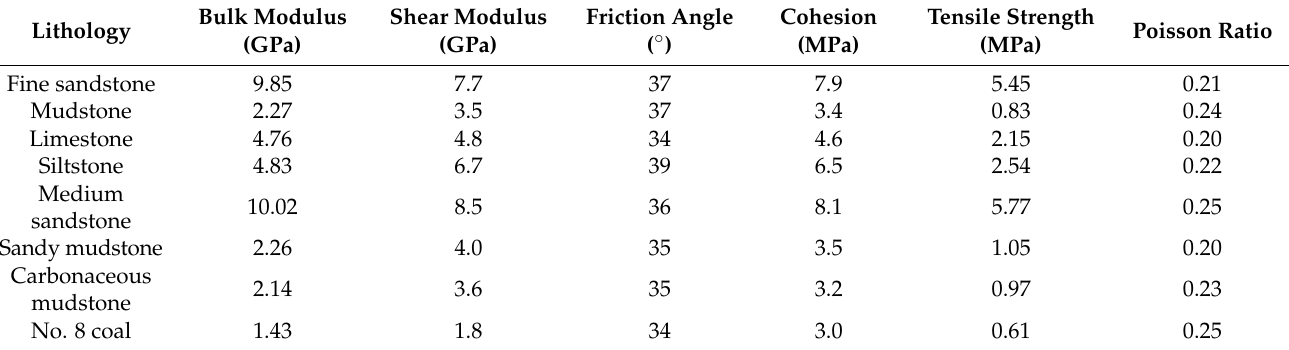
Figure 3. Numerical calculation model. Table 1. Lithologic parameters used in numerical model.